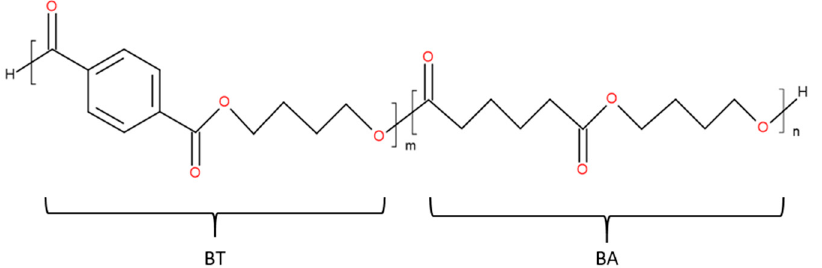
Figure 1. Chemical structure of PBAT.